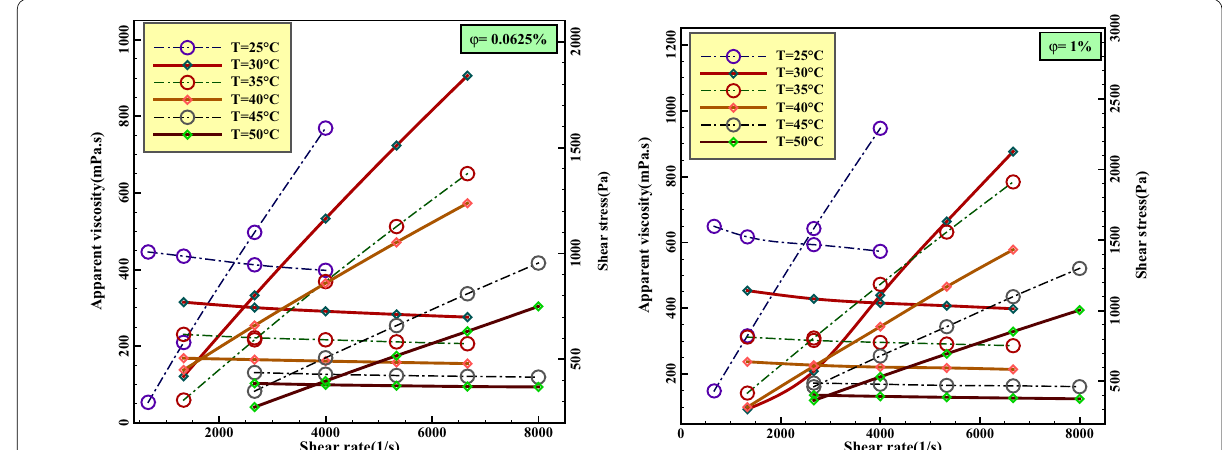
Fig. 6 Shear stress and μ nf change curves versus γ at different temperatures and φ